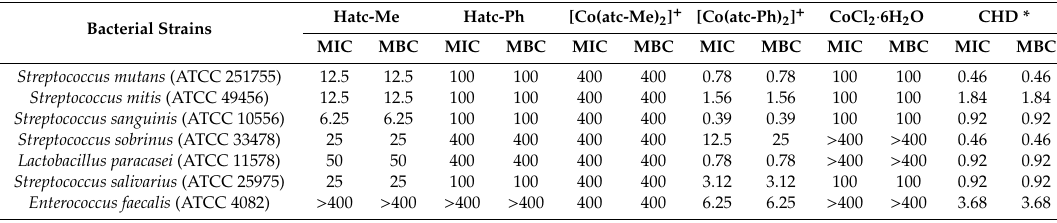
Table 1. Minimum inhibitory concentration (MIC, µ g / mL) and minimum bactericidal concentration (MBC, µ g / mL) in µ g / mL against buccal bacteria